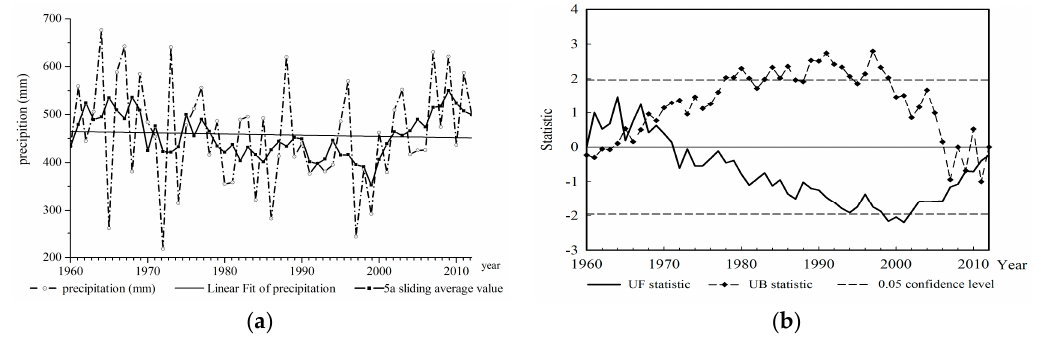
Figure 3. Annual precipitation variation trend and mutation analysis in the Jinci Spring region: ( a ) annual precipitation variation trend; ( b ) annual precipitation mutation analysis.